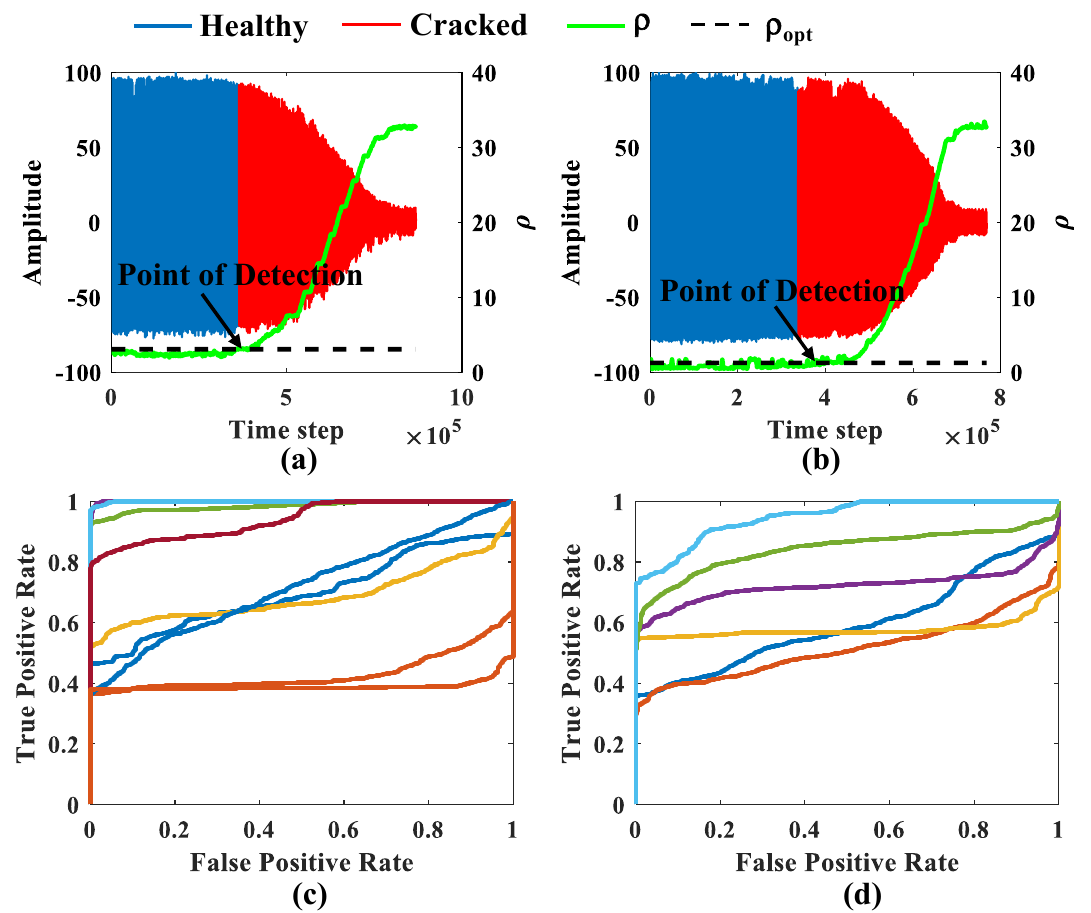
Figure 14. Performance of the training algorithm superimposed on a representative ( a ) U-notched and ( b ) V-notched ultrasonic time-series signal in the CC regime. The values of ρ and ρ opt are plotted on the right axis. ROC curves for 9 individual ( c ) U-notched and ( d ) V-notched training specimens in the CC regime.